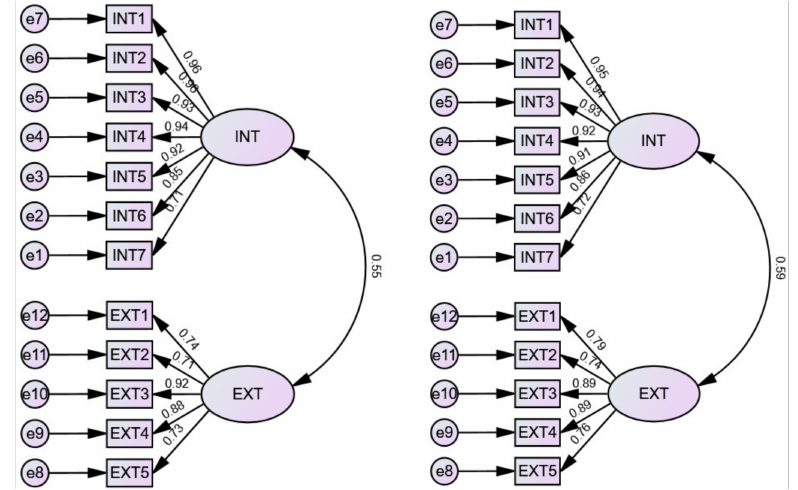
Figure 4. Model 3a and Modal 3b path